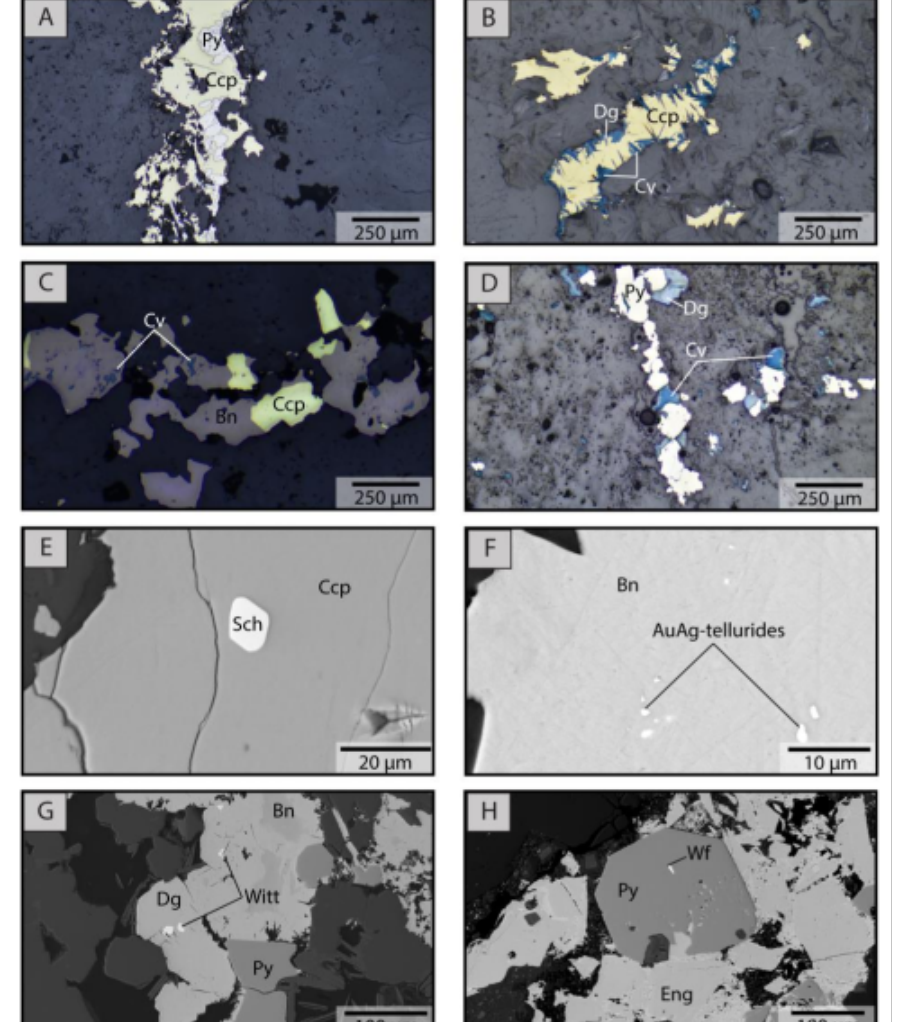
Figure 6. Reflected light photomicrographs and SEM images of chalcopyrite, bornite, and pyrite from representative samples. ( A ) pyrite-chalcopyrite veinlet from the chloritic alteration; ( B ) chalcopyrite replaced by covellite and digenite from the intense potassic alteration; ( C ) covellite and bornite replacing chalcopyrite from the intense potassic alteration; ( D ) pyrite-digenite-covellite veinlet in the quartz-sericite alteration; ( E ) scheelite micro-inclusion in chalcopyrite from the background potassic alteration zone; ( F ) Au-Ag-telluride micro-inclusions in bornite from the intense potassic alteration zone; ( G ) wittichenite inclusions in bornite-digenite in the quartz-sericite alteration zone; ( H ) wolframite micro-inclusion in pyrite from the quartz-sericite alteration zone. Bn: Bornite, Ccp: Chalcopyrite, Cv: Covellite, Dg: Digenite, Eng: Enargite, Py: Pyrite, Sch: Scheelite, Wf: